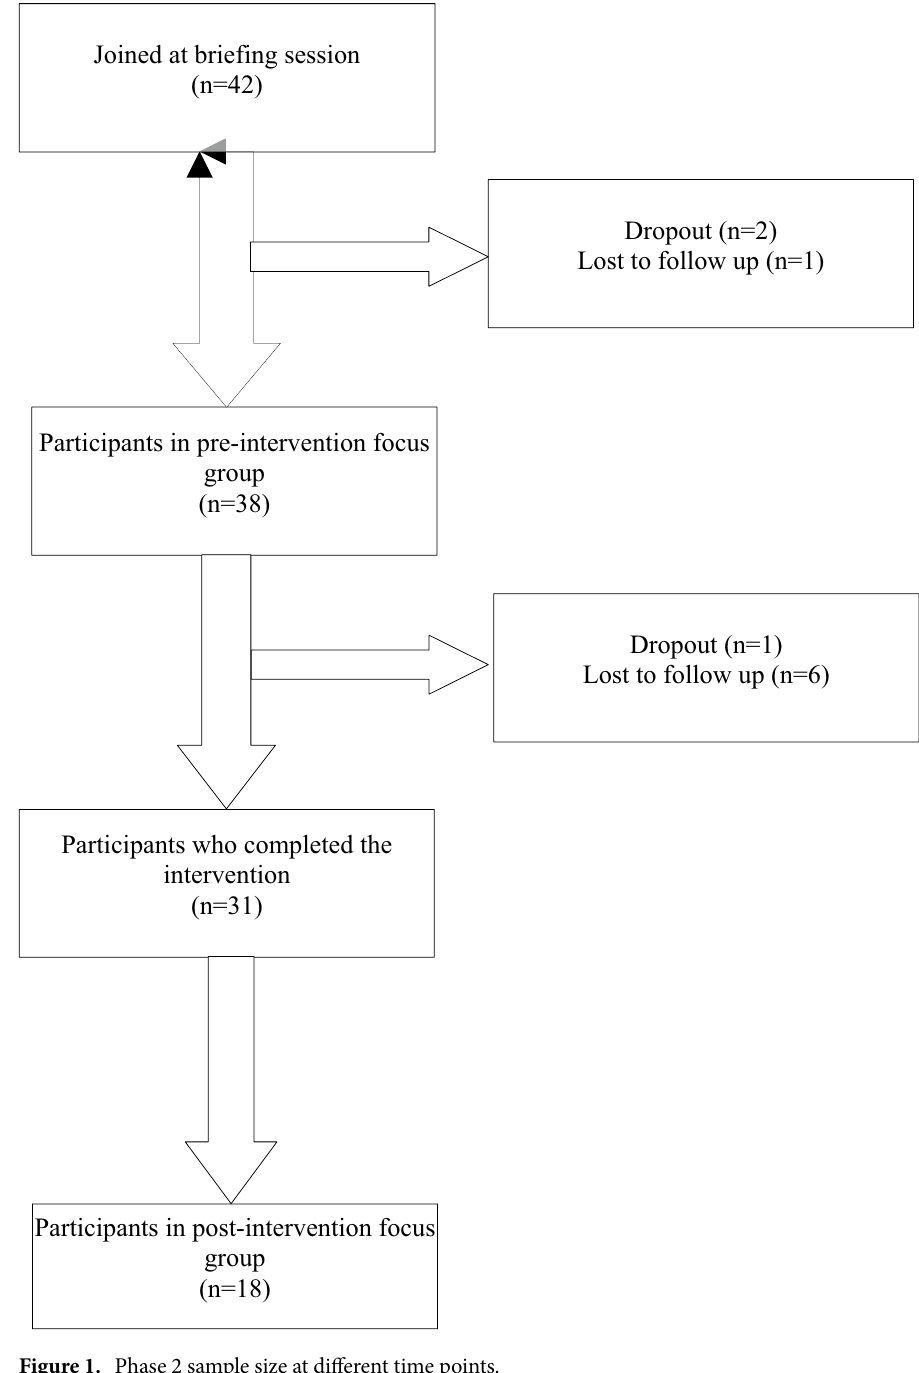
Figure 1. Phase 2 sample size at different time